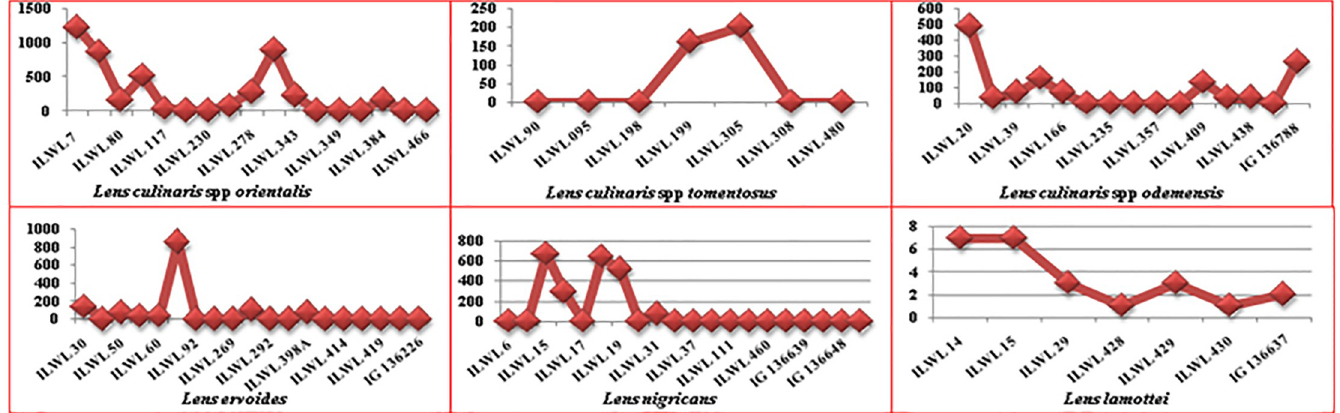
Fig 4. Screening of wild lentil accessions against rust resistance.